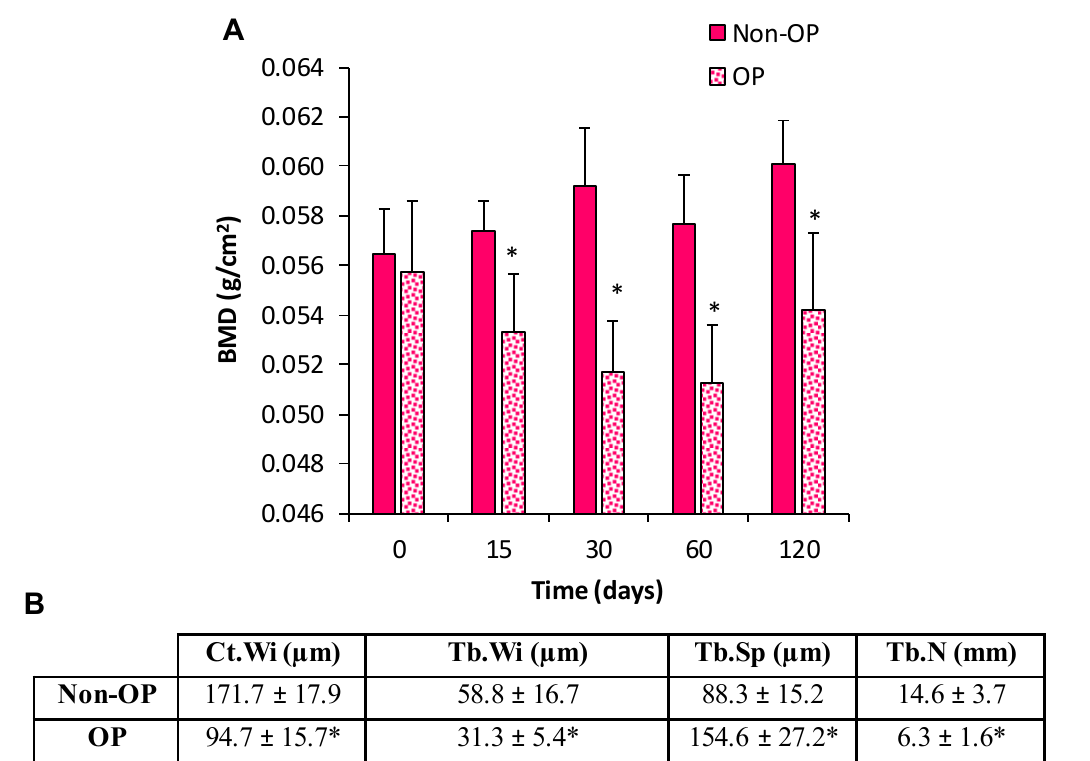
Figure 4. ( A ) Bone mineral density (BMD; g/cm 2 ) values for control and OP animals at 0, 15, 30, 60, and 120 days of ovariectomy. ( B ) Histomophometric analysis in femurs measuring cortical bone width (Ct.Wi) and, in cancellous bone, trabeculae width (Tb.Wi), trabeculae separation (Tb.Sp), and trabeculae number (Tb.N). (*) denotes statistical significance differences compared with non-OP group (control) p < 0.001.